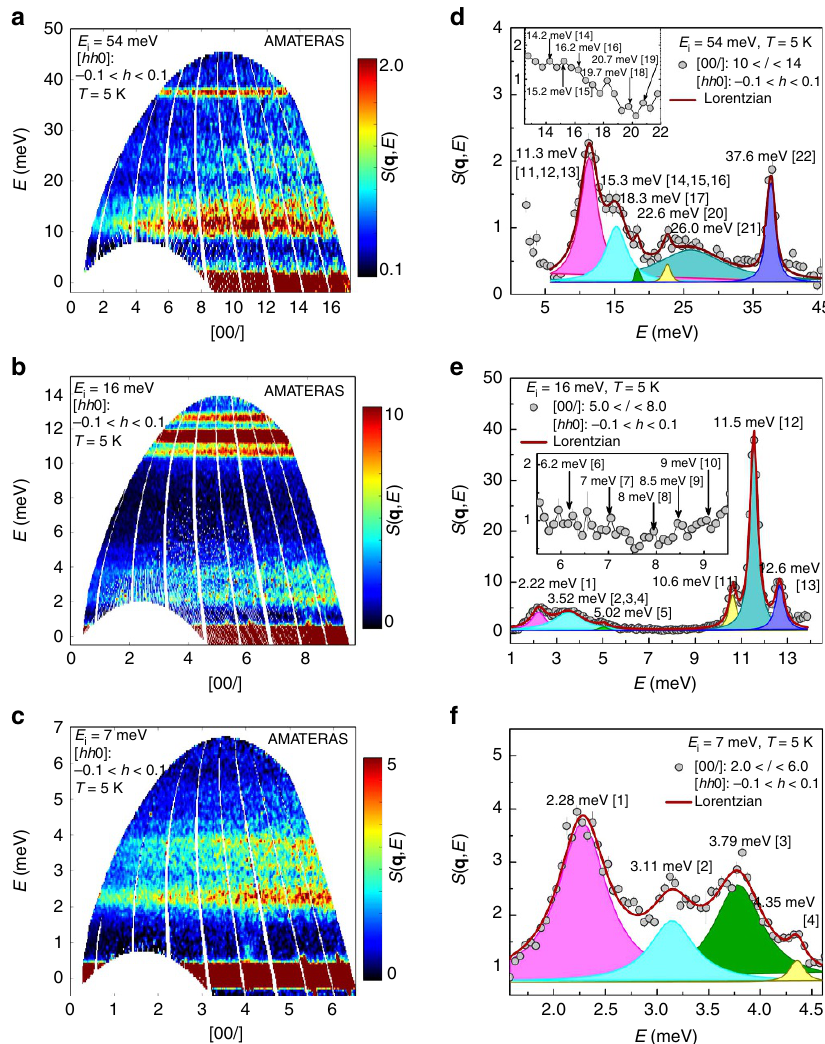
Figure 3 | Longitudinal phonon spectra at 5K along [00 l ] obtained at AMATERAS. ( a – c ) The contour plots of S ( q , E ) obtained with E i of 54, 16 and 7meV. ( d – f ) Momentum-transfer averaged spectra and multiple Lorentzian-function fitting to highlight the energies of modes. The peak position for each component is labelled. The insets highlight small shoulders or humps overlooked by the fitting. For the case of [ hh 0], please refer to Supplementary Fig. energy-transfer (filled square) averaged spectra. The solid lines represent the slopes of dispersion curves near the zone centres, which determine the group velocities: n LA ¼ 2841 m s (cid:2) 1 and n ¼ 1155 m s (cid:2) 1 . Shown in Fig. 4e is the fitting of the TA TA